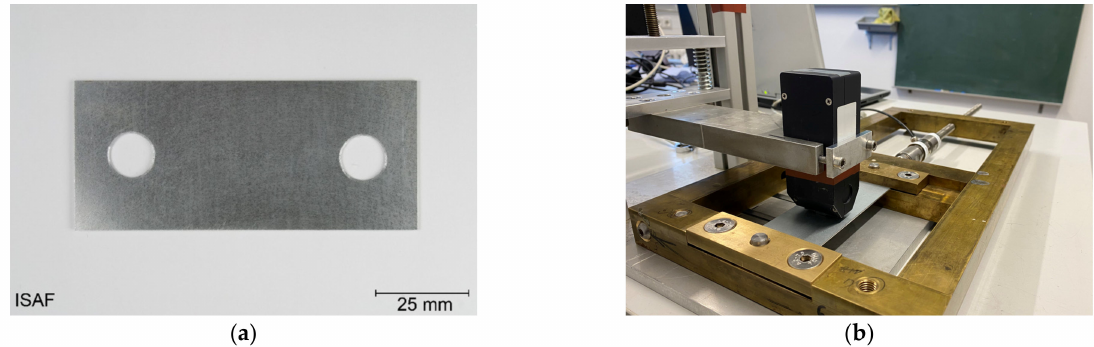
Figure 4. ( a ) Sample form for measuring magnetic properties and the ( b ) testing device.